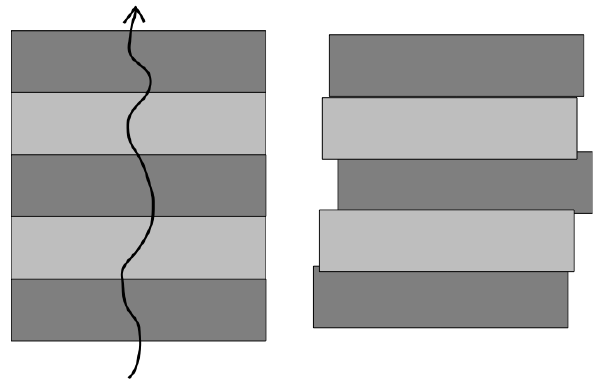
Figure 1. Cartoon illustrating effects of jitter in pushbroom imaging. Left) Camera motion with exaggerated jitter over the ground target. Right) Reconstructed image with jitter